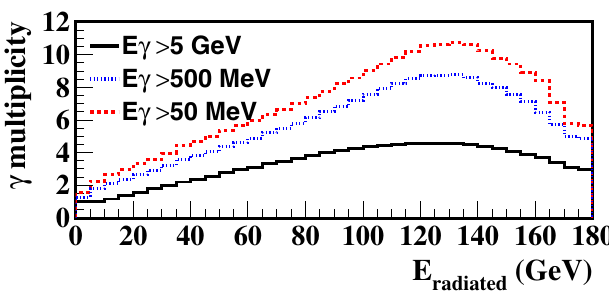
FIG. 1. (Color) Monte Carlo prediction for photon multiplicity vs total radiated energy using different photon energy cutoff